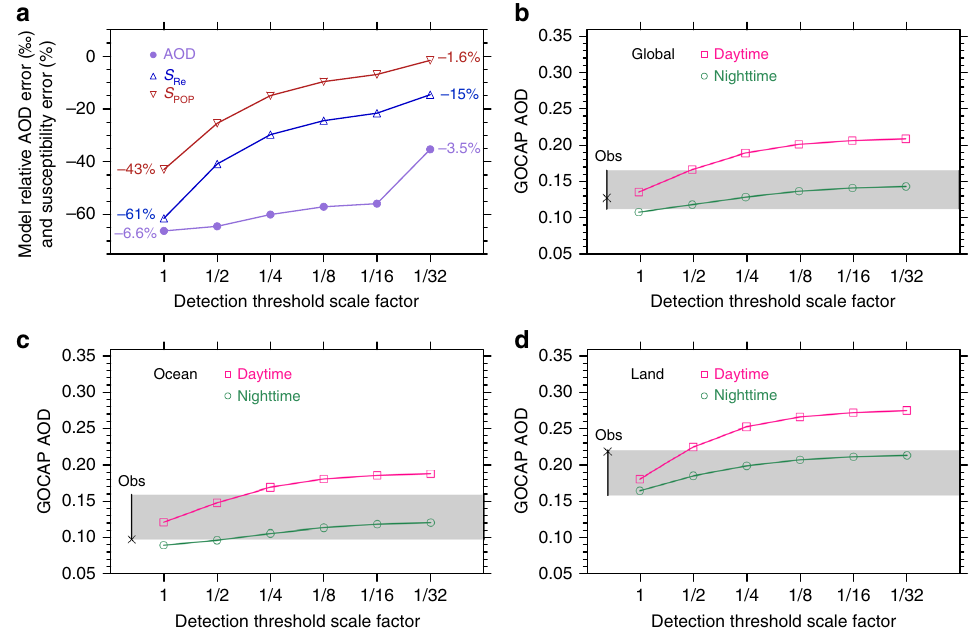
Fig. 5 Model mean aerosol optical depth error, susceptibility errors, and the climatology of observational aerosol optical depth as a function of detection threshold scale factor. The a AOD and susceptibility errors relative to CAM5_orb, b global GOCAP AOD, c GOCAP AOD over ocean, and d GOCAP AOD over land, are shown. Shaded area represents the range of observational estimates from other satellites including the MODIS Collection 6 35, 72 , the Multi- angle Imaging Spectroradiometer (MISR) Version 4 73 – 75 , the sea-viewing wide fi eld-of-view sensor (SeaWIFS) Version 4 76 – 78 , the operational